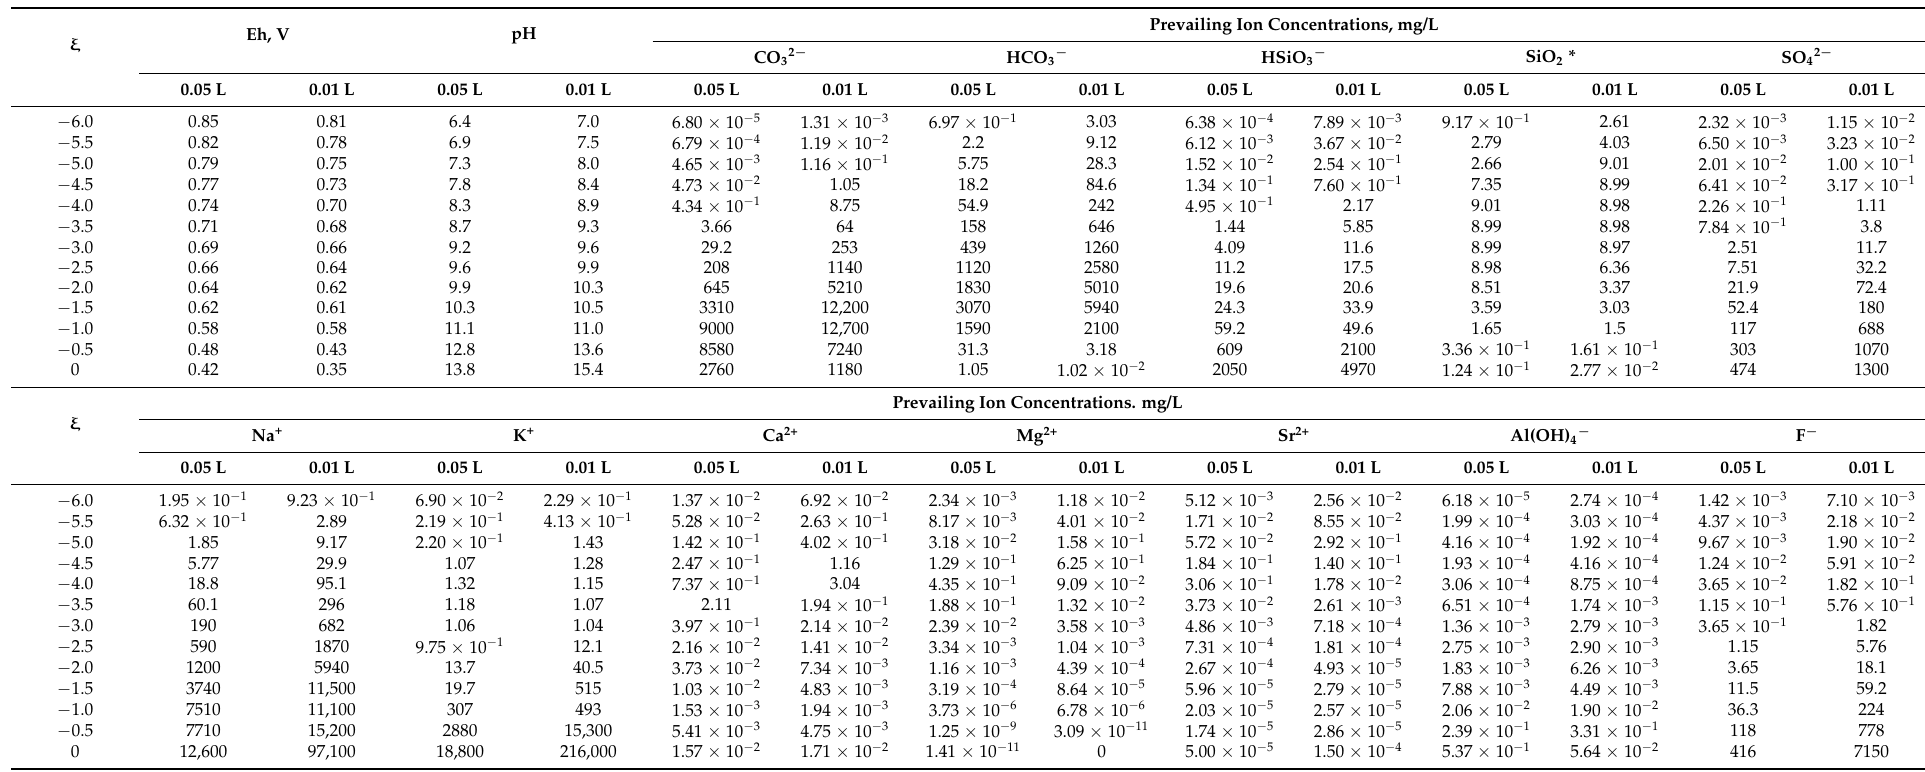
Table 4. Change in Eh, pH, and concentrations of prevailing ions at 0.05 and 0.01 L of water in the